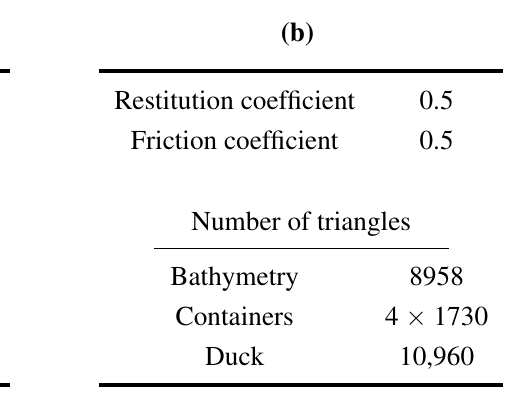
Table 2. Simulation parameters of the debris flow test case. ( a ) ELBE ; ( b )